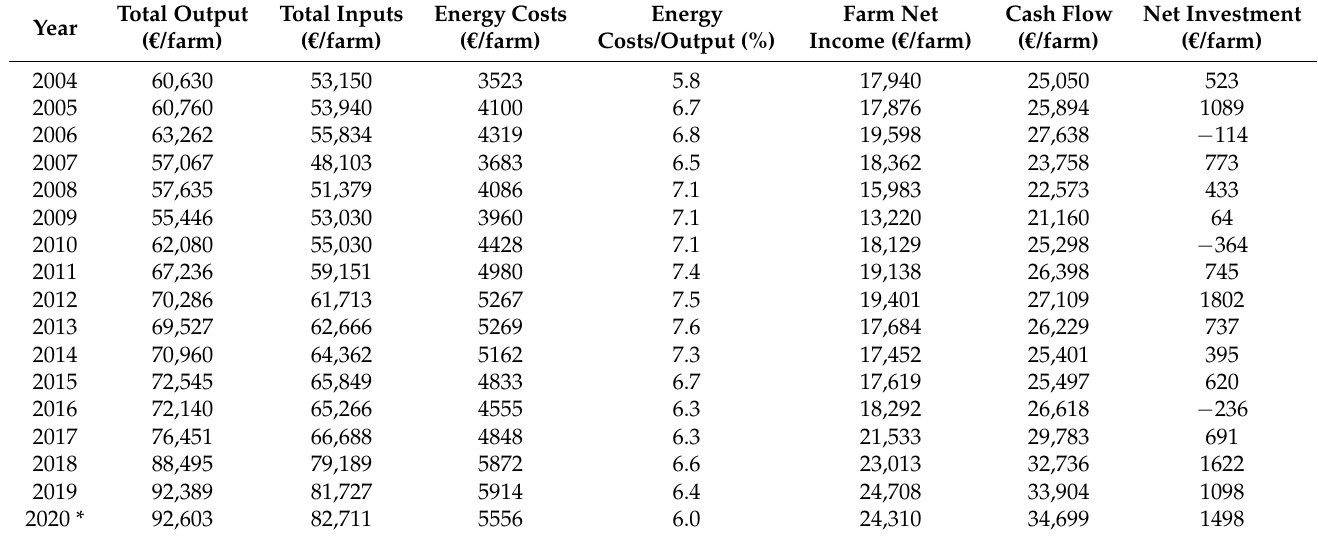
Table 1. Information about the financial situation of farms in the European Union in 2004–2020.